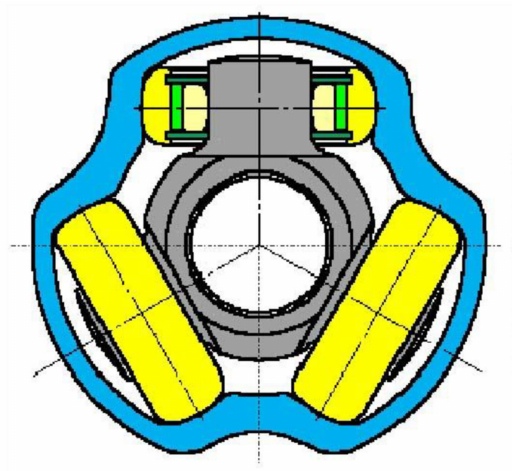
Figure 9. Cross-section of the tulip-tripod